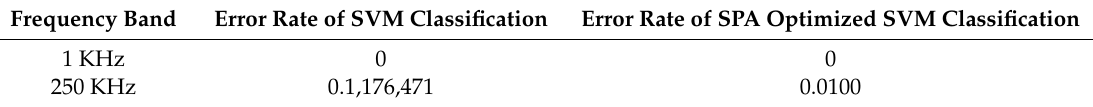
Table 3. Comparison of the classification accuracy in the two frequency